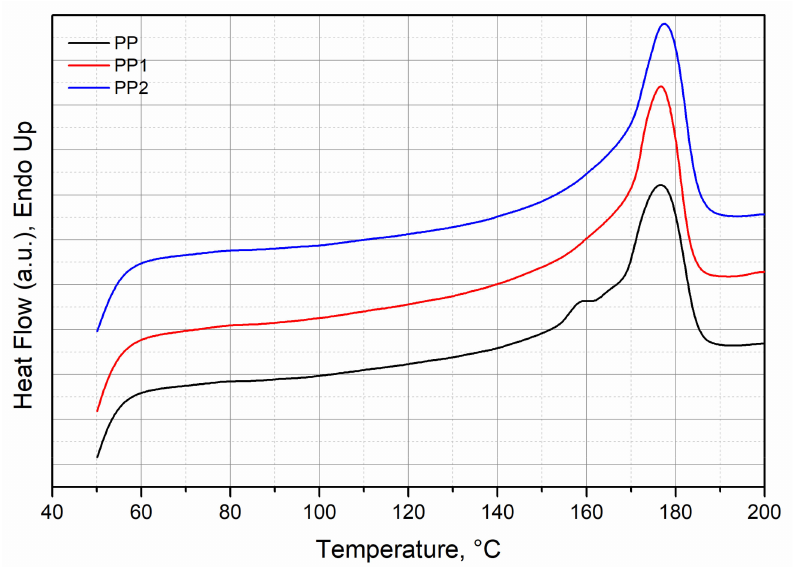
Figure 3. Thermograms recorded during the second heating scan of polypropylene and polypropy- lene nanocomposites.